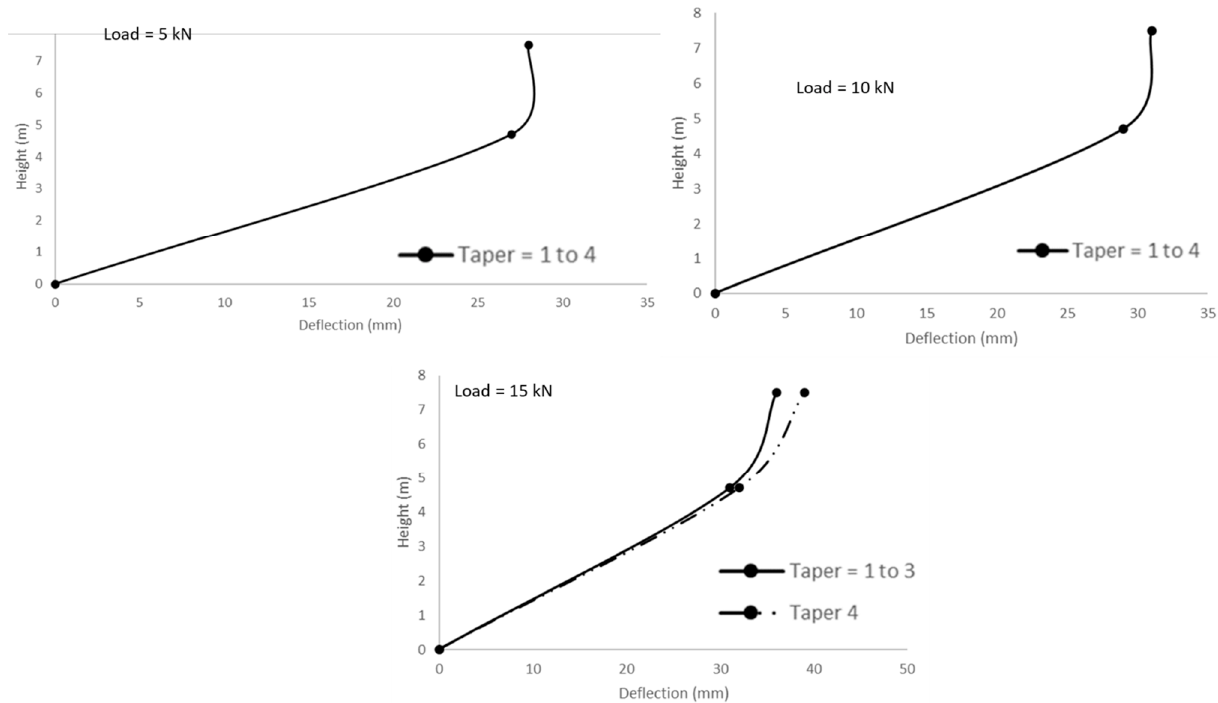
Figure 5. Behavior variation of the taper versus tree height (m) for the scenario 3 (tree height 7.5 m; slenderness 22) and for simulated horizontal forces (5 kN, 10 kN and 15 kN). Taper 1 = 0.010, Taper 2 = 0.020, Taper 3 = 0.030, and Taper 4 =